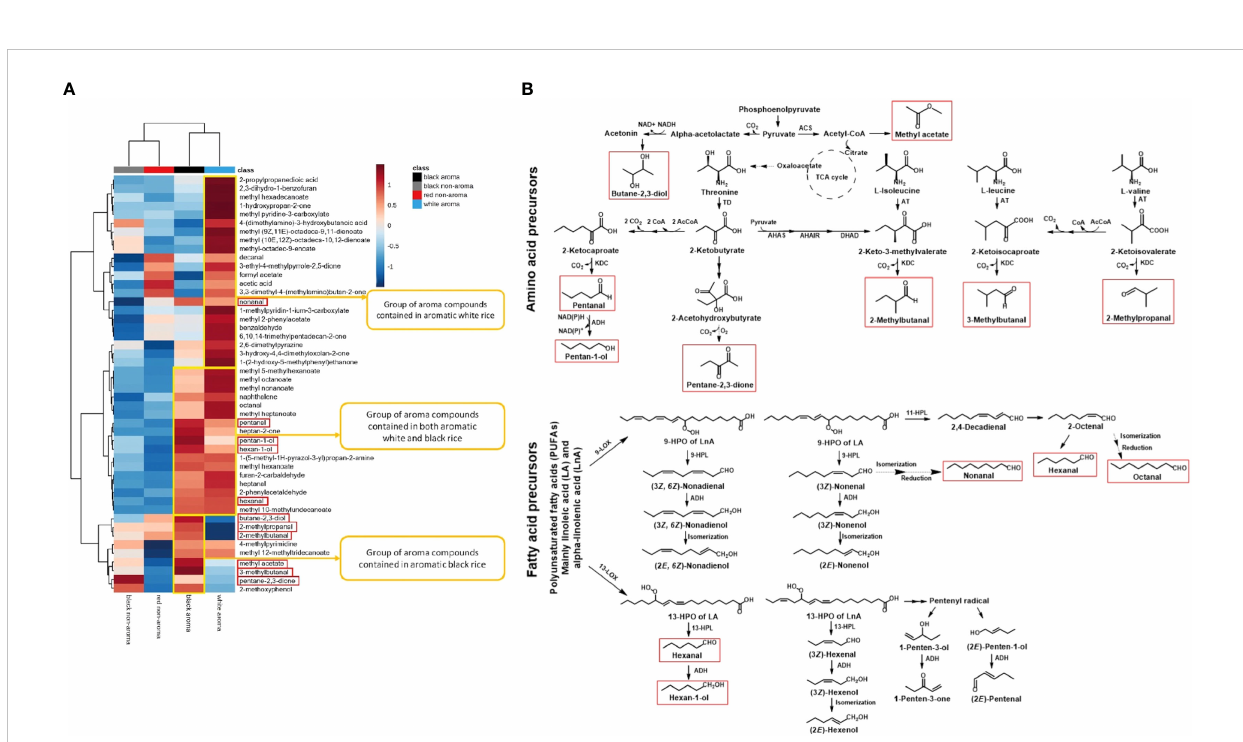
FIGURE 5 (A) Hierarchical clustering heatmaps of volatile compounds identi fi ed in aromatic white, aromatic black, non-aromatic black, and non-aromatic red rice samples. Warm color (red) indicates an increase of volatile compounds while cold color (blue) indicates a decrease of volatile chemical levels. The key and main volatile products detected in Thai black-aroma rice are highlighted by red-square frames which was proposed to be biosynthesized via the pathways summarized in (B) . (B) The proposed biosynthetic pathways in Thai aroma-black rice of various volatile aldehydes and alcohols starting from related fatty acid and branched-chain amino acid precursors. The key and main volatile products detected in Thai black- aroma rice highlighted in A are also highlighted with the same red-square frames. LOX; lipoxygenase, HPL; hydroperoxide lyase, ACS; Acetyl-CoA synthetase, TD; threonine dehydratase, AT; aminotransferase, AHAS; acetohydroxyacid synthase, AHAIR; acetohydroxyacid isomeroreductase, DHAD; dihydroxyacid dehydratase, KDC; 2-keto acid decarboxylases and ADH; alcohol